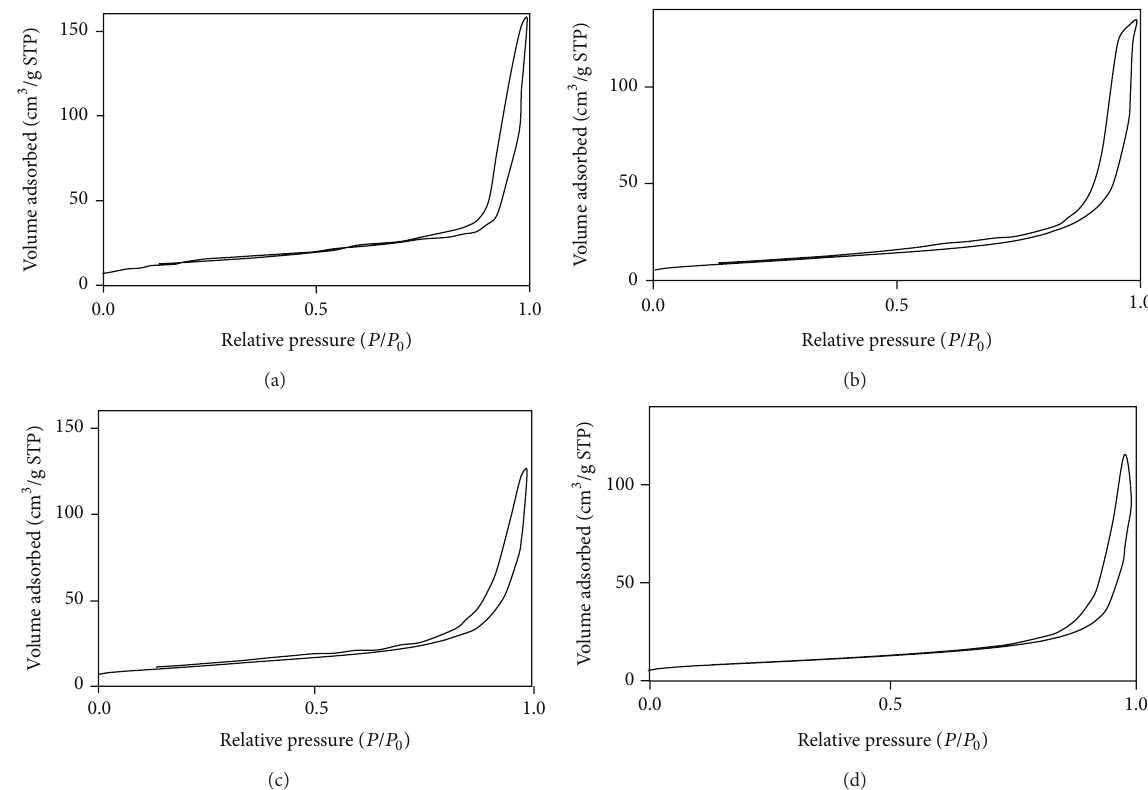
Figure 2: N 2 adsorption-desorption hysteresis at 77 K of prepared catalysts after calcinations ((a) HLB = 13.9, (b) HLB = 23.7, (c) HLB = 31.2, and (d) HLB = 40).